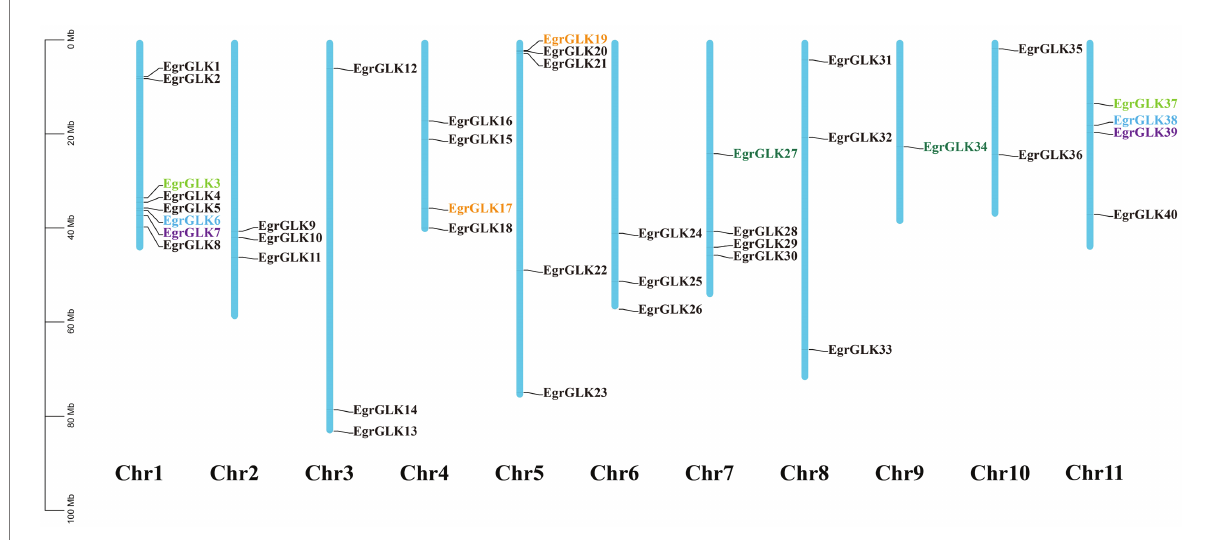
FIGURE 1 Chromosomal location of EgrGLK genes in Eucalyptus grandis . Genes of the same color represents a pair of segmented duplicated genes, and genes of different colors represent different gene pairs. No segmental duplication in black genes.